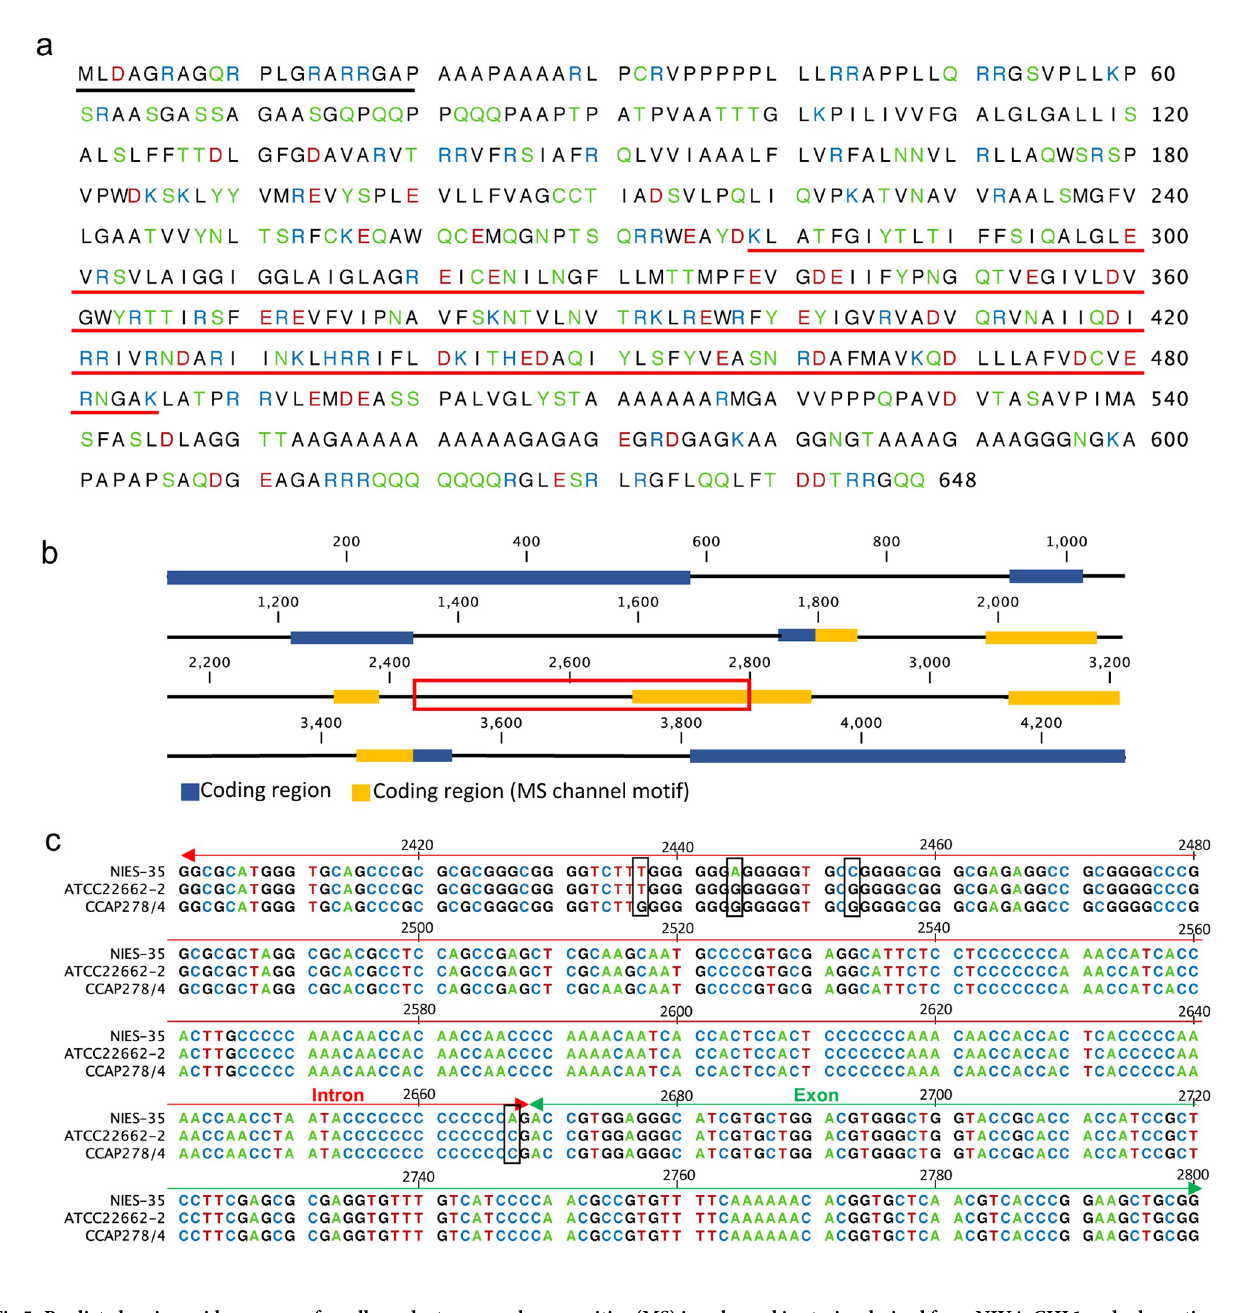
Fig 5. Predicted amino acid sequence of small-conductance mechanosensitive (MS) ion channel in strains derived from NIVA-CHL1 and schematic representation of its gene. (a) The predicted amino acid sequence; amino acid numbers beginning from the initiator methionine are shown on the right. Black underline, signal peptide; red underline, MS channel motif. (b) Structure of the gene (Rsub_08752) encoding MS ion channel. Boxes, exons; lines, introns. (c) Alignment of DNA sequences enclosed in the red box in (b). Single-nucleotide polymorphisms are shown by black boxes. ATCC 22662–2 (2304 mg/L) and CCAP 278/4 (2497 mg/L) were higher than that of NIES-35 (1600 mg/L) (Fig 6C). To evaluate the ability to adapt to external osmotic stress, we compared cell diameter at 72 h after the onset of NaCl exposure among the three strains (Fig 6D). Cell diameter tended to be larger in ATCC 22662–2 and CCAP 278/4 than in NIES-35 in the control